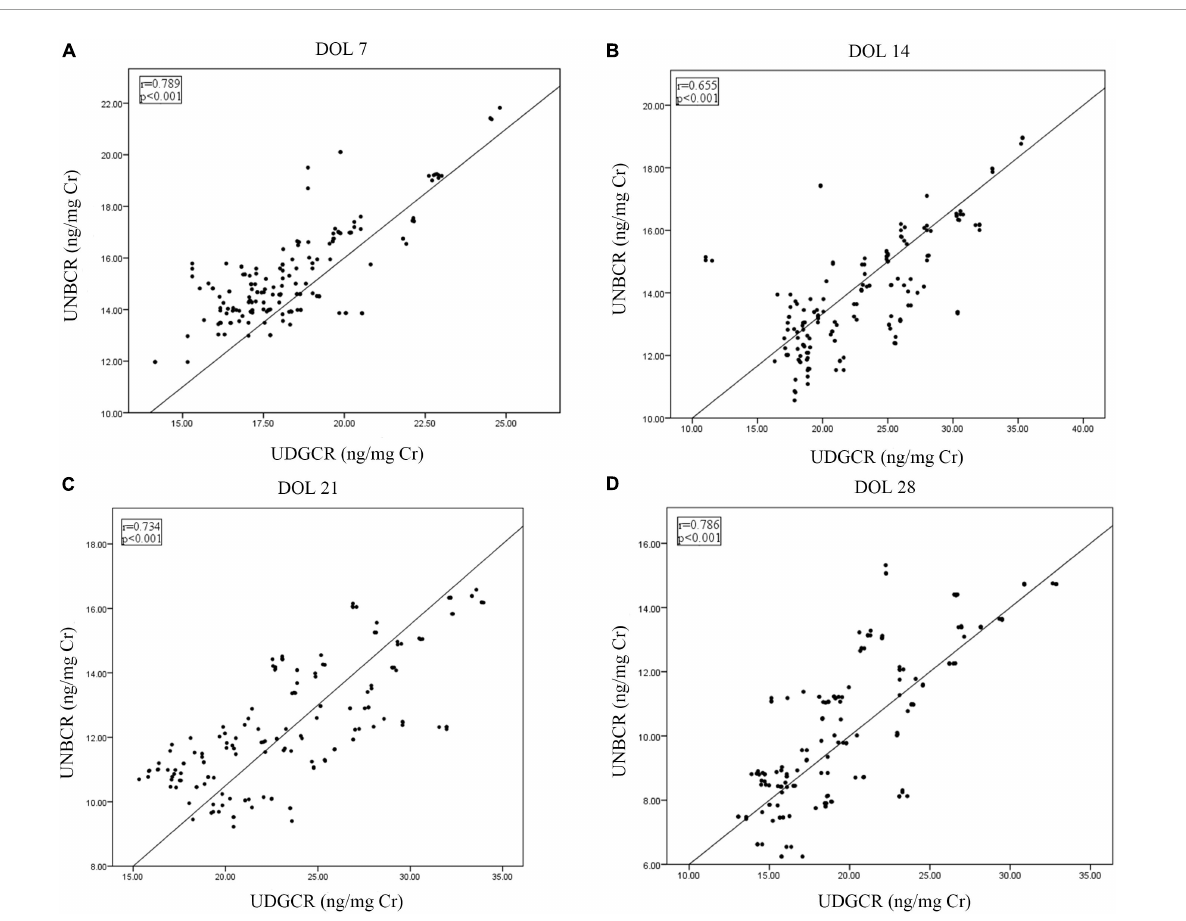
FIGURE2 Correlations between urine 8-OHdG and NT-proBNP from DOL 7 to 28 (A–D) . 8-OHdG, 8-hydroxy-2’-deoxyguanosine; DOL, days of life; NT-proBNP, N-terminal pro-brain natriuretic peptide; UDGCR, urinary 8-OHdG/creatinine ratio; UNBCR, urinary NT-proBNP/creatinine ratio.